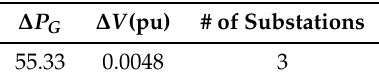
Table 6. Results of CVR